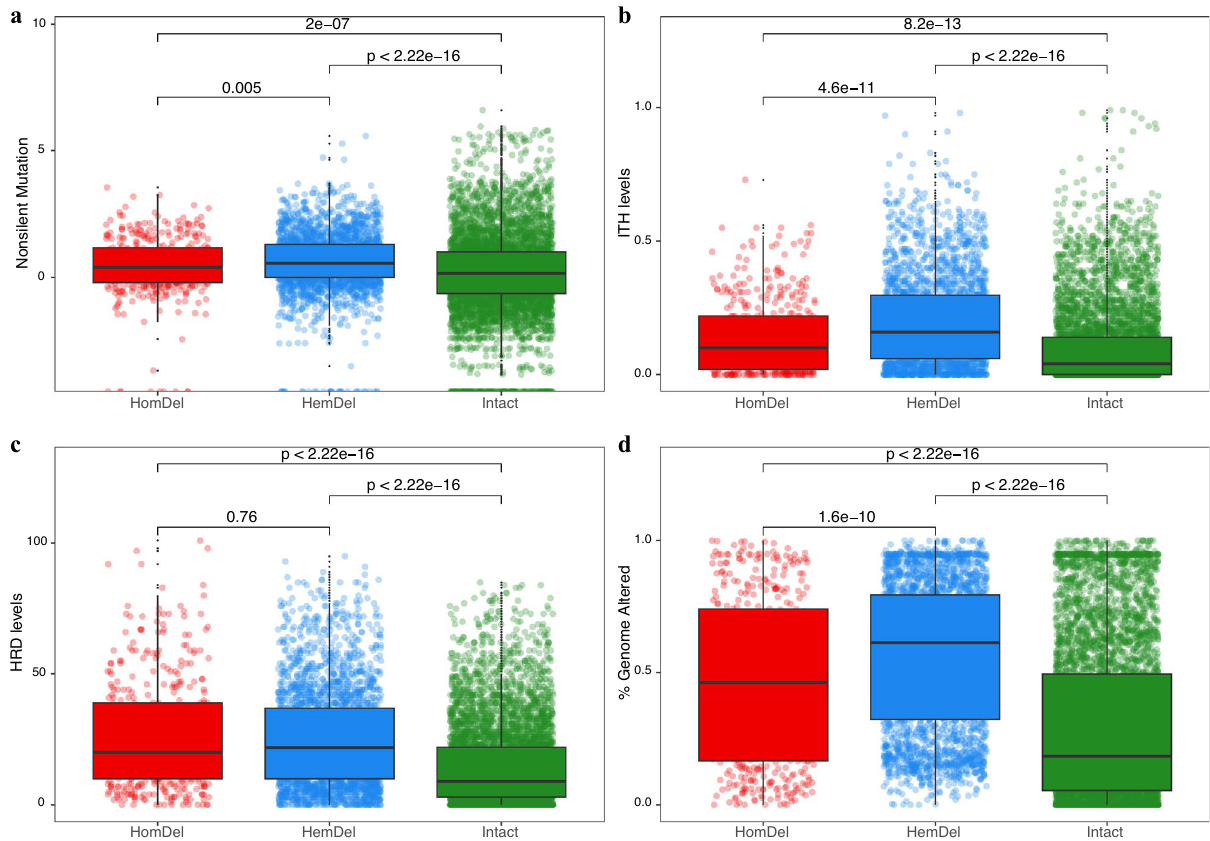
Figure 4. PTEN deletions are associated with ( a ) increased mutation levels, ( b ) intra-tumor heterogeneity (ITH), ( c ) homologous repair defects (HRD), and ( d ) percent genome alteration. Hemizygous deletions of PTEN are associated with increased levels of genomic alterations compared with homozygous deletions. Intact PTEN showed the lowest levels of genomic alterations. Plotted using ggplot2 (https:// ggplo t2. tidyv erse.